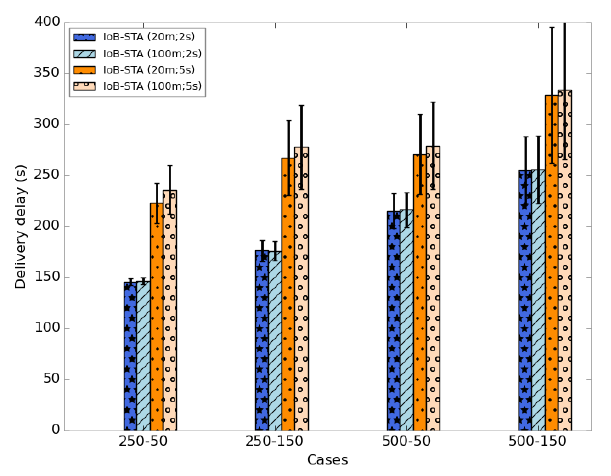
Figure 35. Average throughput for IoB-STA.